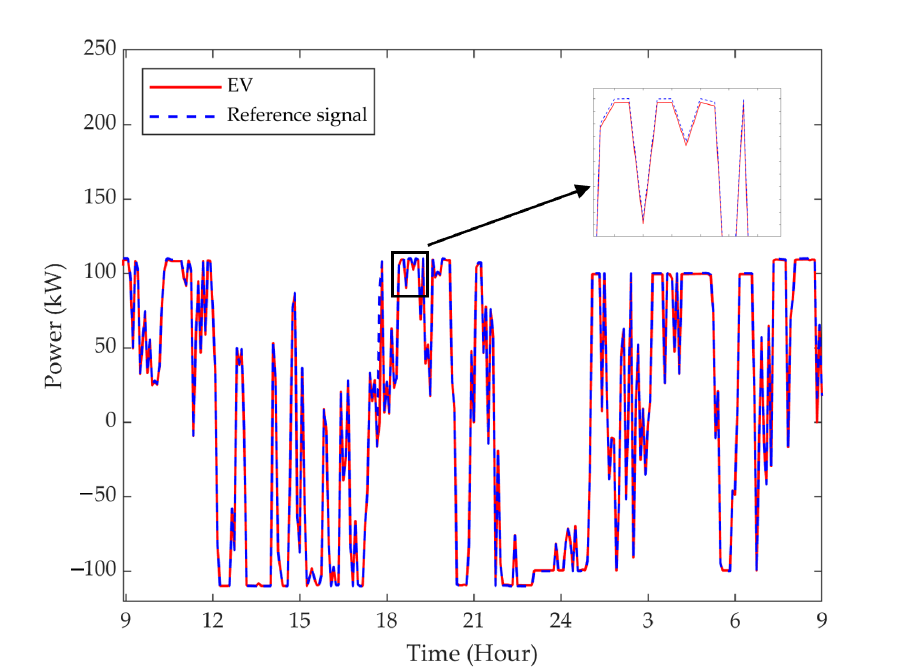
Figure 6. Aggregated EV charging and discharging profile from 9 a.m. on the first day to 9 a.m. on the second day for frequency regulation in Scenario